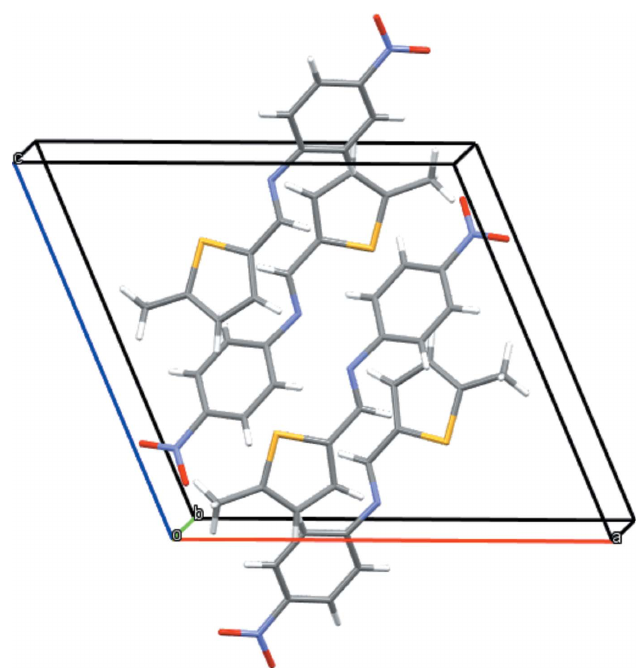
Figure 2 A view of the unit-cell packing along